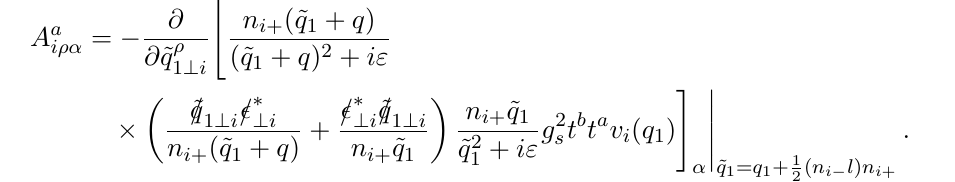
Figure 4 . Relevant diagrams for the mixing J B 1 J B 1 i j